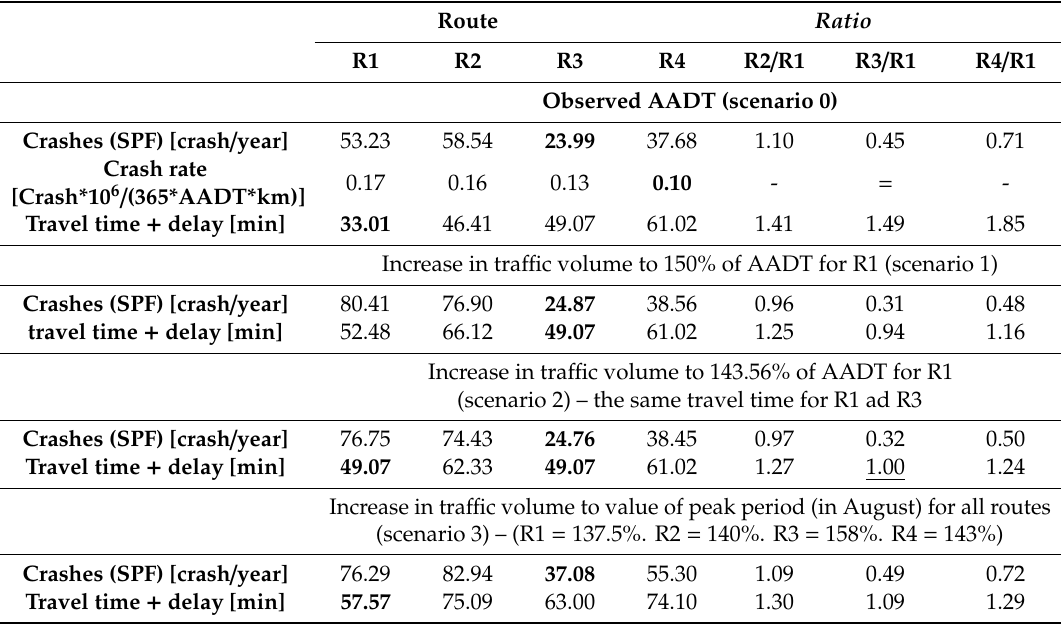
Table 7. Values of crashes and travel time for all routes (the lowest values are in